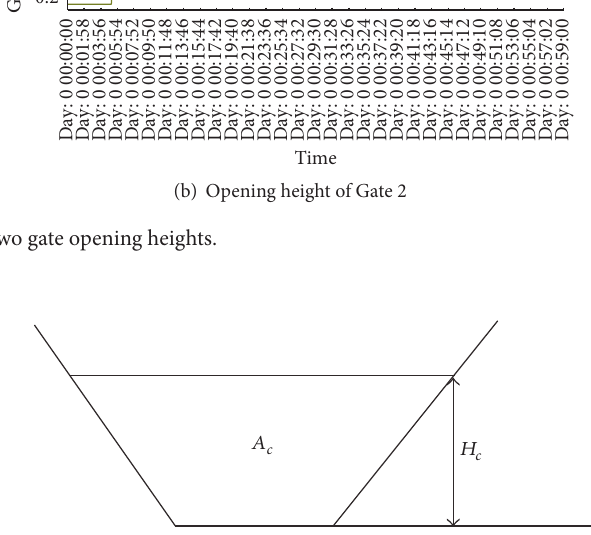
Figure 7: Schematic of a constant trapezoidal cross